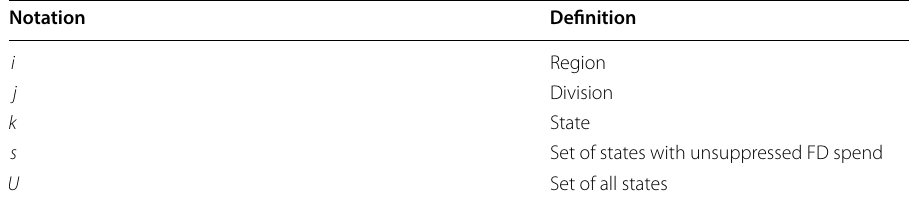
Fifteen of the largest states in terms of population and retail sales are in italics Table 4 Subscript and set